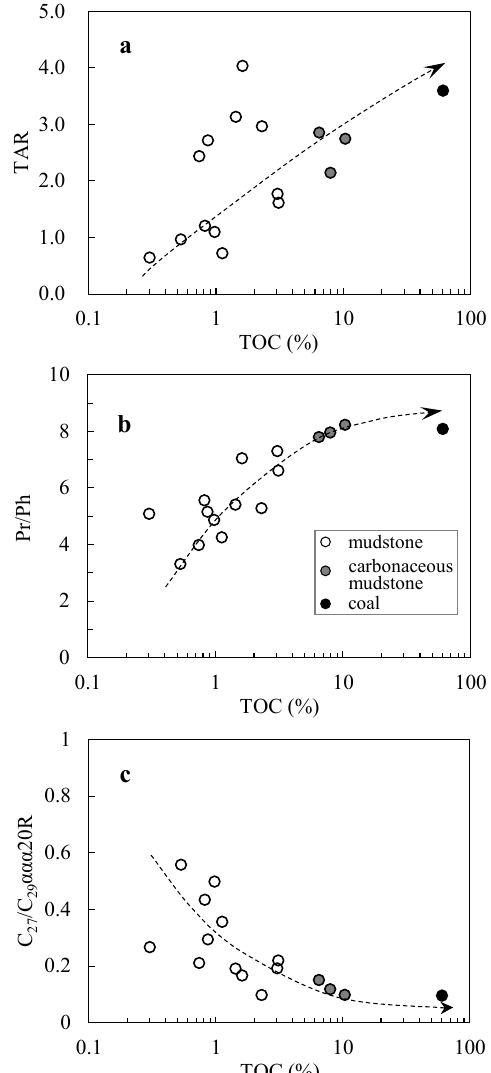
Figure 10. Cross-plots of TOC versus TAR ( a ) Pr/Ph, ( b ) and C 27 /C 29 ααα 20R sterane, ( c ) for the studied source rocks.